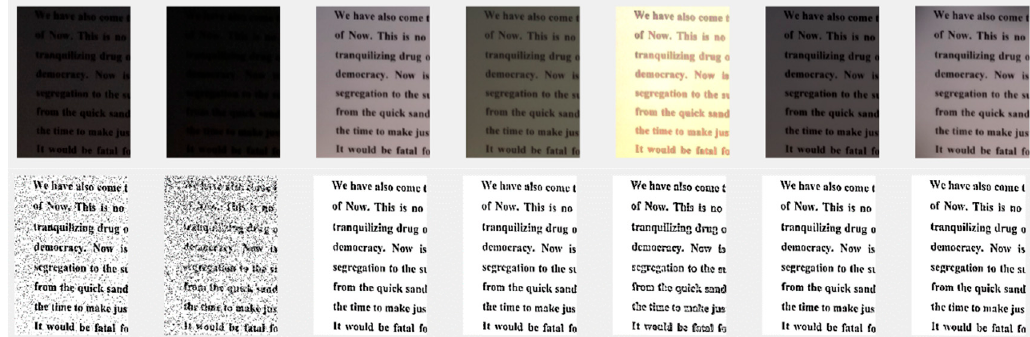
Figure 13. One under-exposed region in well-exposed images. From left to right: well-exposed image, under-exposed image, over-exposed image, ReinhardTMO HDR image, DurandTMO HDR image, Goshtashy fusion, and the Merten fusion method. The images in the top row correspond to RGB images and the images in the bottom row correspond to binary images.